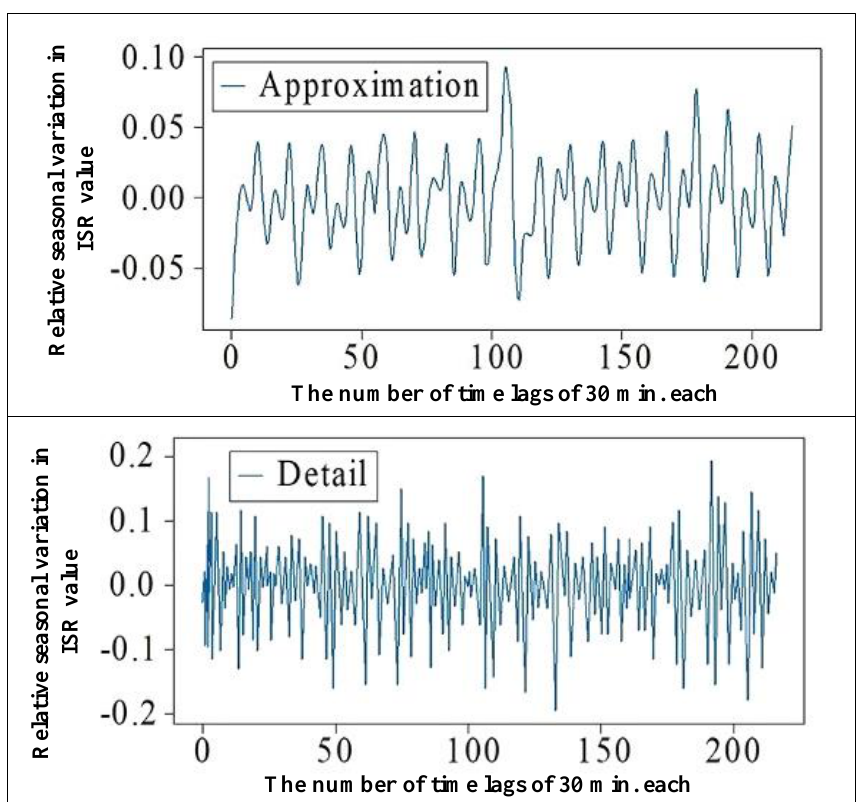
The number of time lags of 30 min. Figure 5. Approximation Data Generated Using EWT